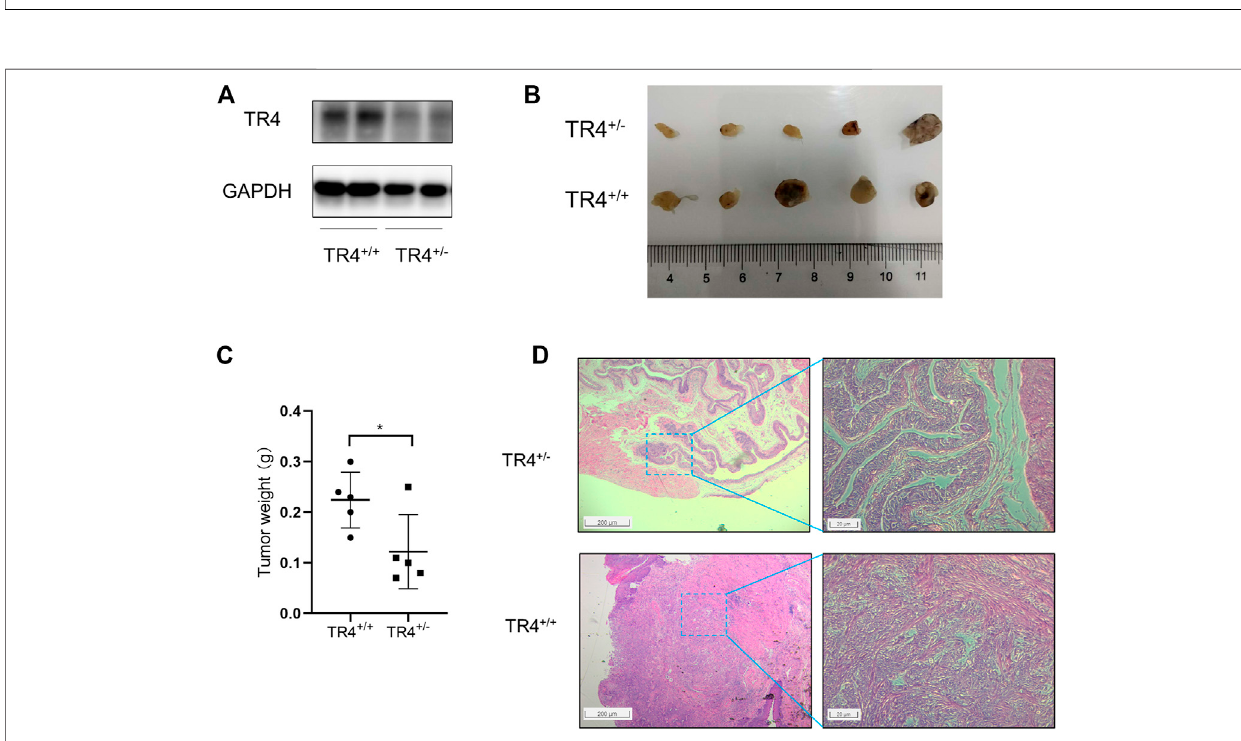
FIGURE 7 | TR4 promotes BC growth in vivo. (A) TR4 expressions of TR4 +/+ and TR4 +/ − mice were con fi rmed by the Western blot. GAPDH was the internal reference. (B) The tumors were observed after 20weeks in two different groups (TR4 +/+ group and TR4 +/ − group). (C) The tumors were weighed and analyzed with Student ’ s t-test between two groups, * p < 0.05. (D) Representative images of HE staining of tumors from the two groups. The left panel shows presentative images, while the quanti fi cation is shown in the right panel (magni fi cation: × 100 (left) and 400 × (right)).